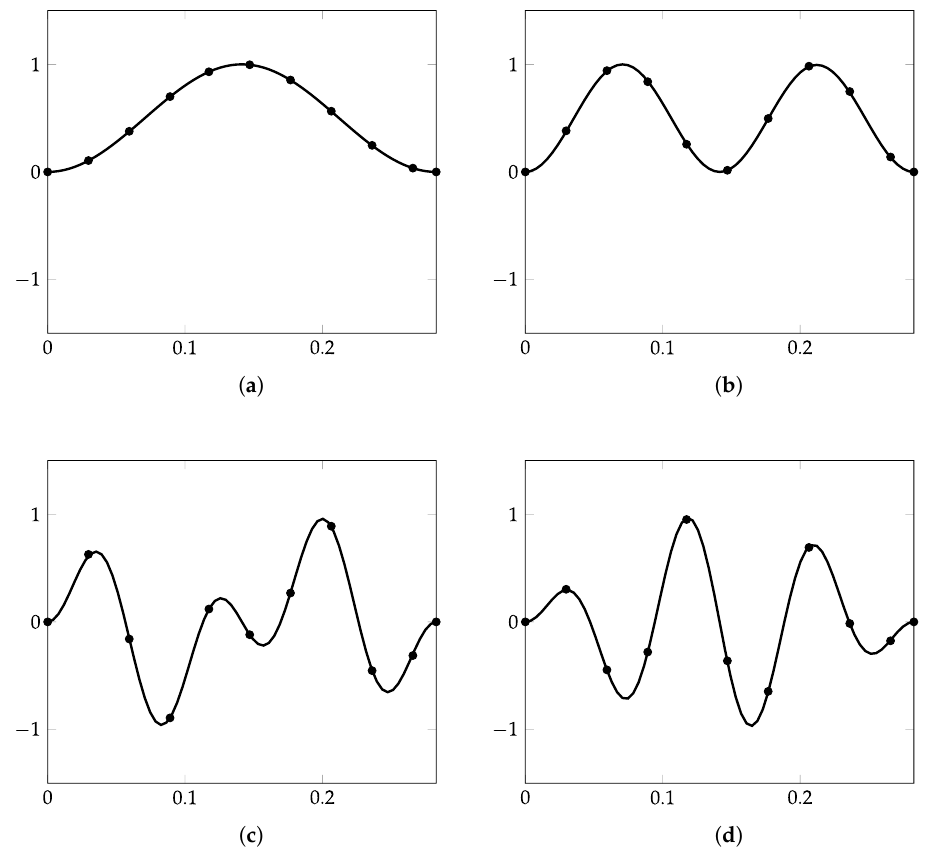
Figure 8. Simply supported LRMP in Figure 3, view along the line x = y of the real part of the modes: ( a ) 127, ( b ) 130, ( c ) 144, and ( d ) 150; dynamic-stiffness approach (black continuous line) and finite-element method in ABAQUS (black dots).